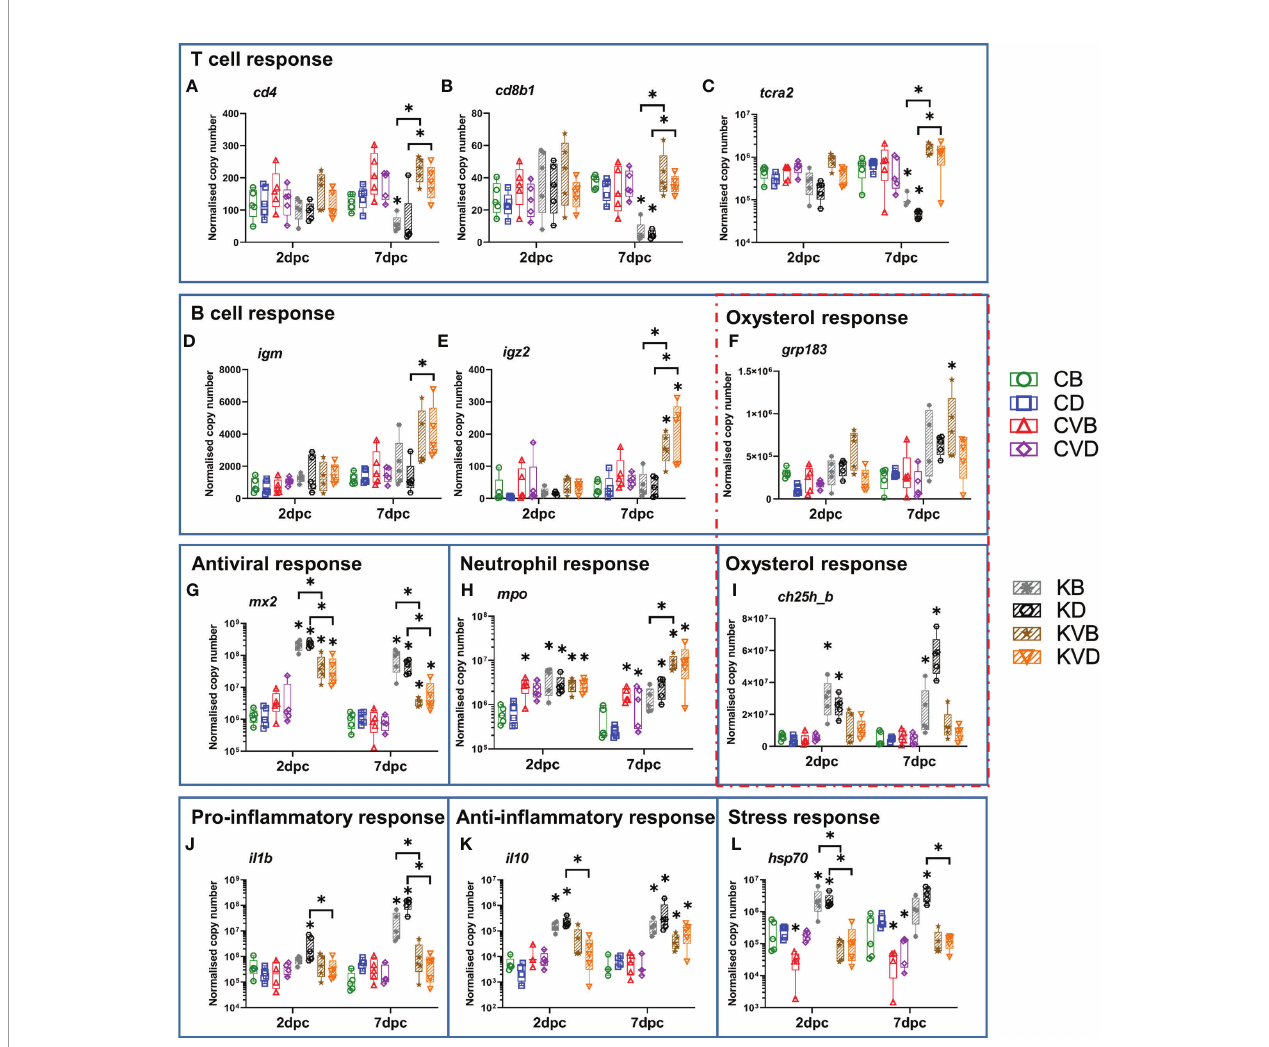
FIGURE 6 | Level of transcripts coding for proteins involved in immune responses after the CyHV-3 challenge at 2 dpc and 7 dpc measured with classical RT-qPCR and integrated fl uidic circuit nanoscale RT-qPCR in skin. Presented are selected markers for T cell response: (A) cd4 , (B) cd8b1 , (C) tcra2 , B cell response: (D) igm , (E) igz2 , (F) grp183 which is also involved in oxysterol response, antiviral response (G) mx2 , neutrophil-speci fi c response: (H) mpo , oxysterol response: (I) ch25h_b , pro- in fl ammatory response: (J) il1b , anti-in fl ammatory response: (K) il10 , stress response: (L) hsp70. The description of experimental groups: CB – BSA, non-vaccinated, unchallenged control, CD – defensins, non-vaccinated, unchallenged control, CVB – BSA, vaccinated, unchallenged control, CVD – defensins, vaccinated, unchallenged control, KB - BSA non-vaccinated, CyHV-3 challenged, KD – defensins non-vaccinated, CyHV-3 challenged, KVB – BSA, vaccinated, CyHV-3 challenged, KVD – defensins, vaccinated, CyHV-3 challenged. The results are presented as 25%-75% box plots with min. and max. values as whiskers with indication of all data points. The data are shown as normalised copy numbers. * indicates statistical signi fi cant difference at p < 0.05. Statistical analysis was performed with two-way ANOVA with multiple comparisons test performed with the Holm-Sidak